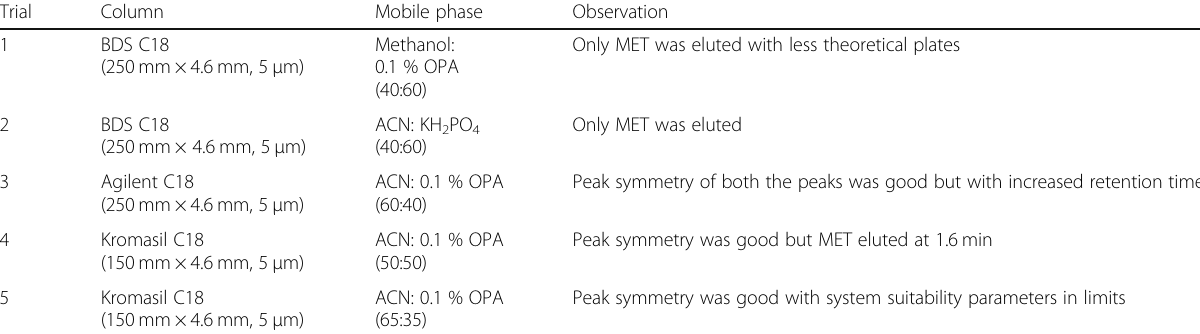
Table 1 Preliminary trial